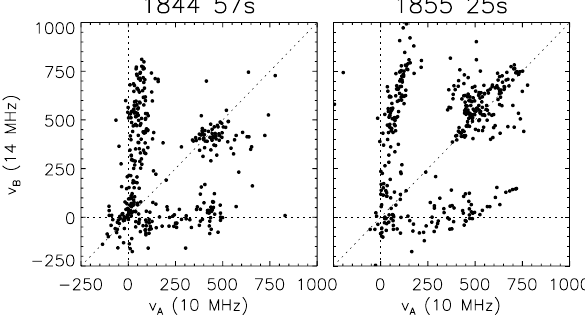
Fig. 10. Similar to Fig. 8, showing a comparison of Doppler shifts measured on channels A and B for the two scans presented in Fig.